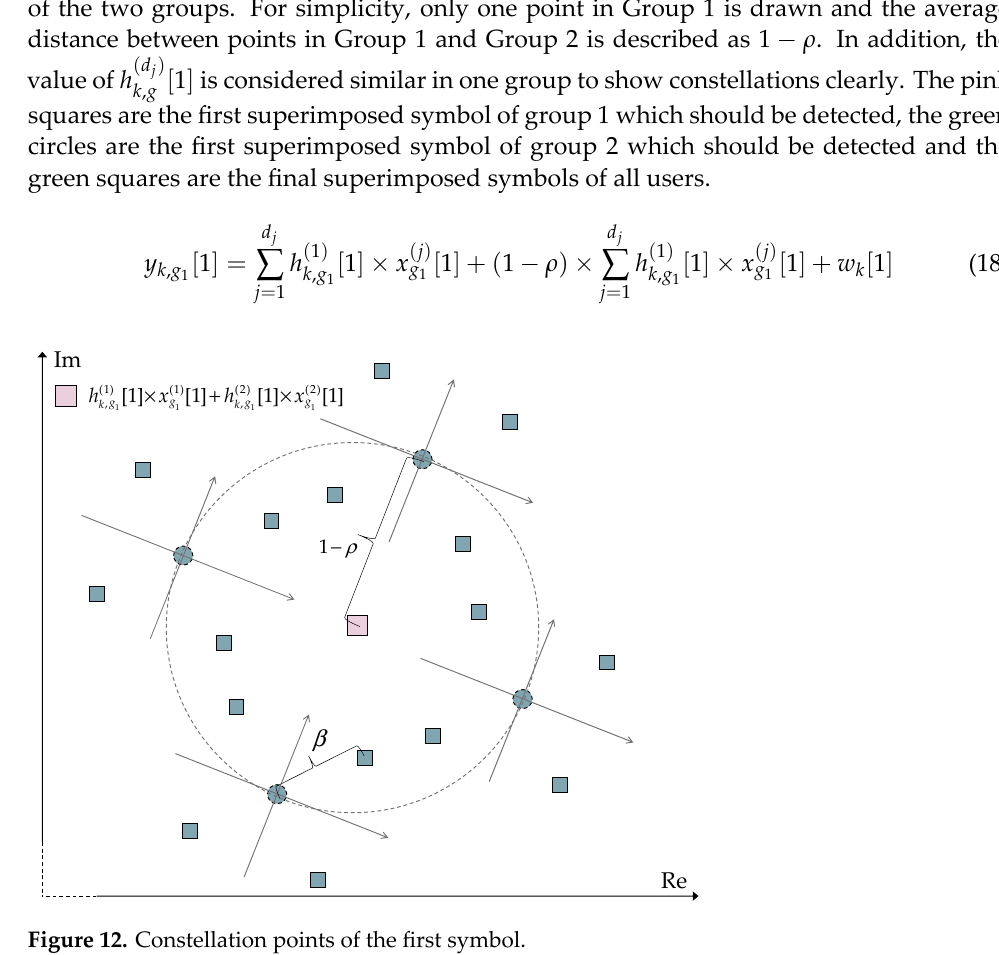
Figure 12. Constellation points of the first symbol.